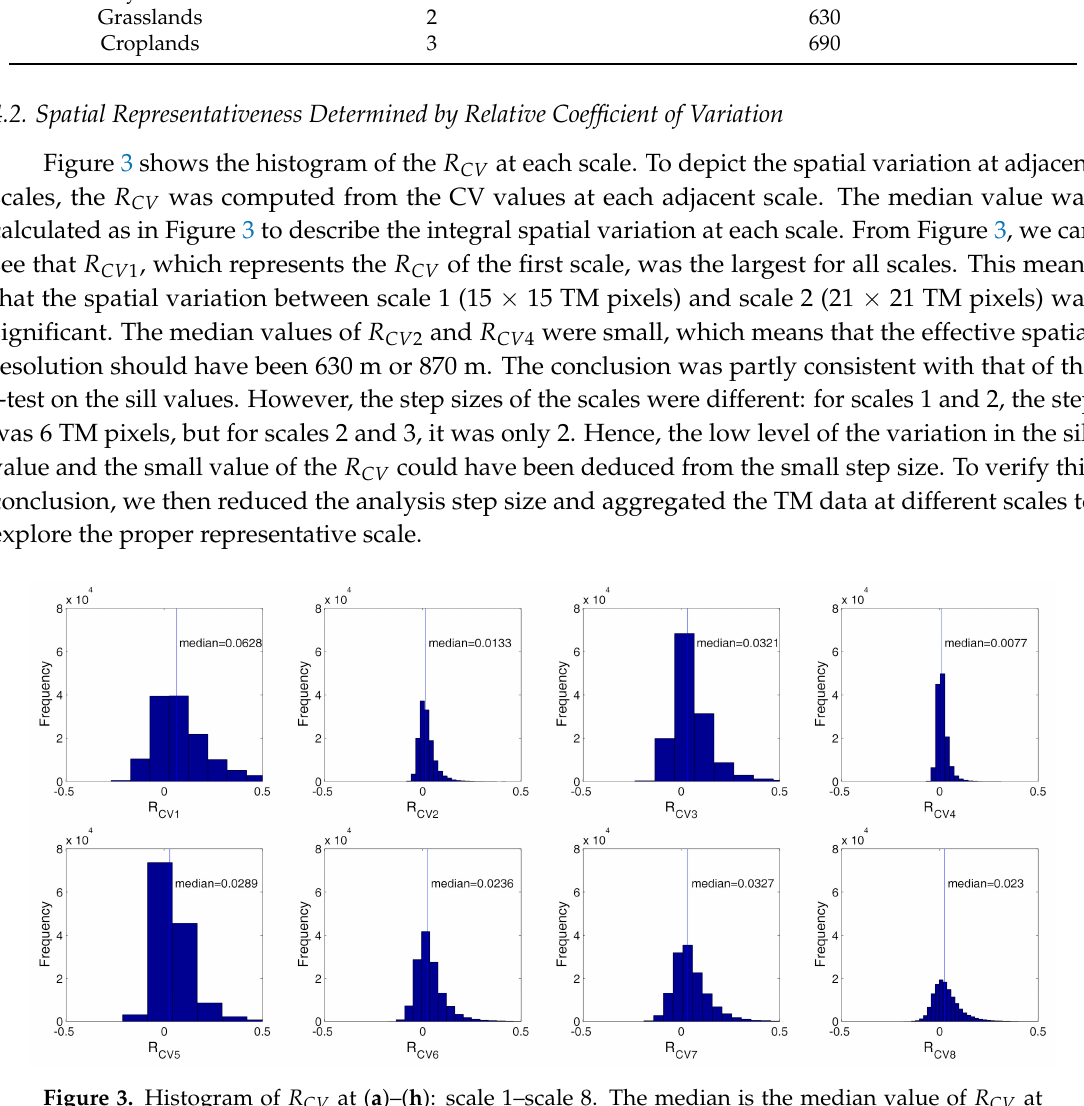
Figure 3. Histogram of R CV at ( a )–( h ): scale 1–scale 8. The median is the median value of R CV at each scale.